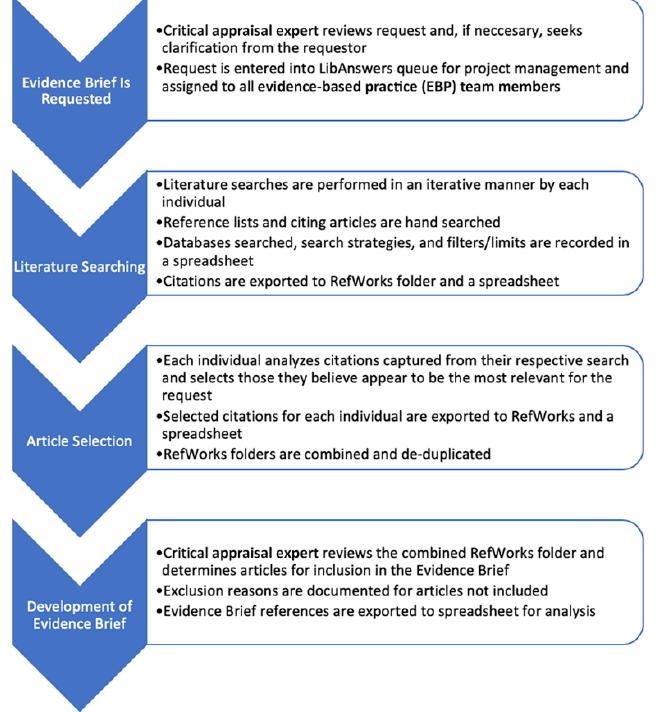
Figure 1 Flowchart of the process for the quality improvement (QI)